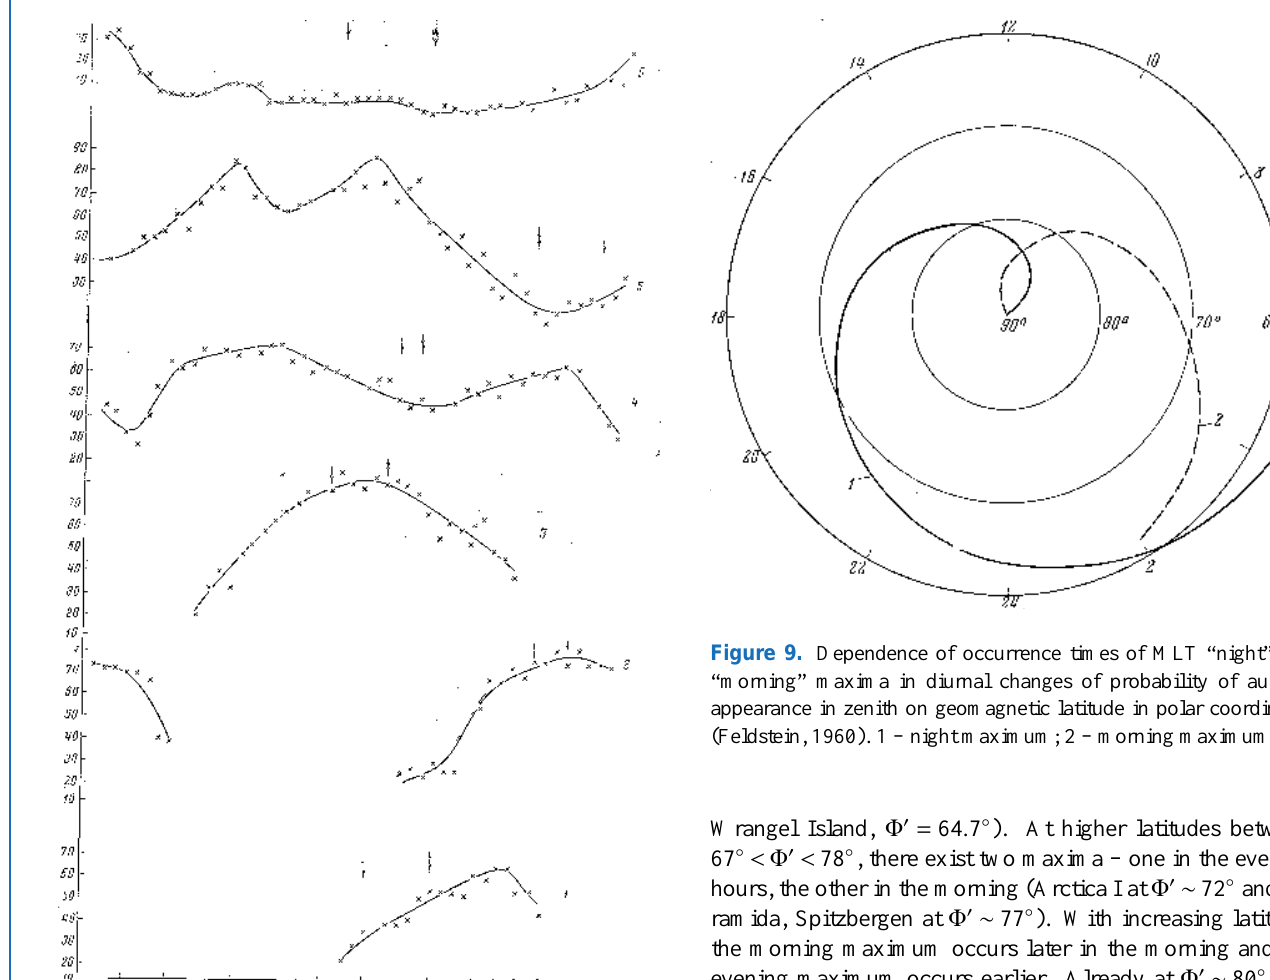
Wrangel Island, Φ 0 = 64 . 7 ◦ ). At higher latitudes